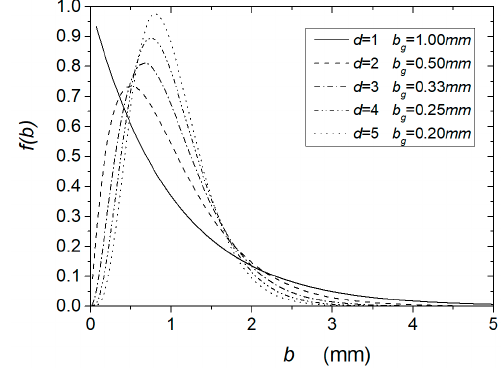
Figure 4. Gamma distribution pdf for di ff erent values of the parameter d and assuming a mean fracture Figure 4. Gamma distribution pdf for different values of the parameter 𝑑 and assuming a mean aperture (cid:104) b (cid:105) = 1 fracture aperture 〈𝑏〉 = 1 mm.